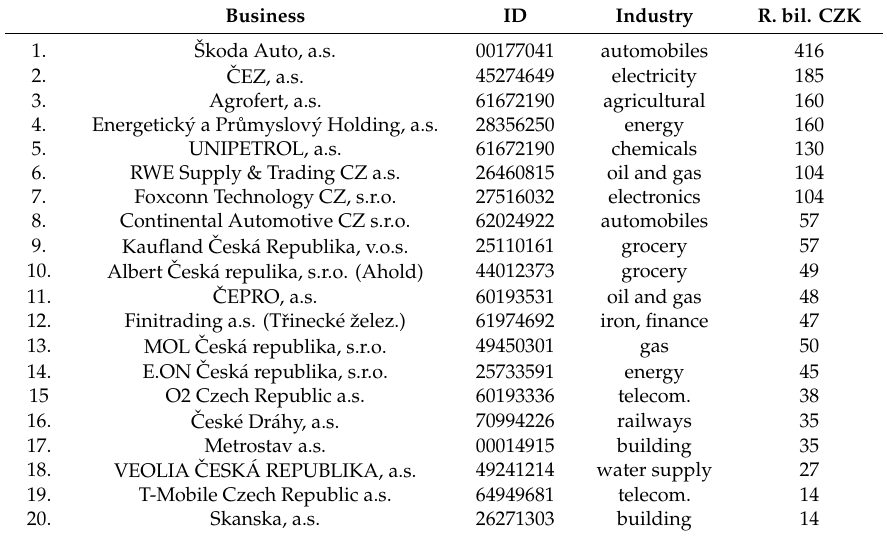
Table 2. Case study—first group—the largest Czech business with codes based on revenue in billion CZK.